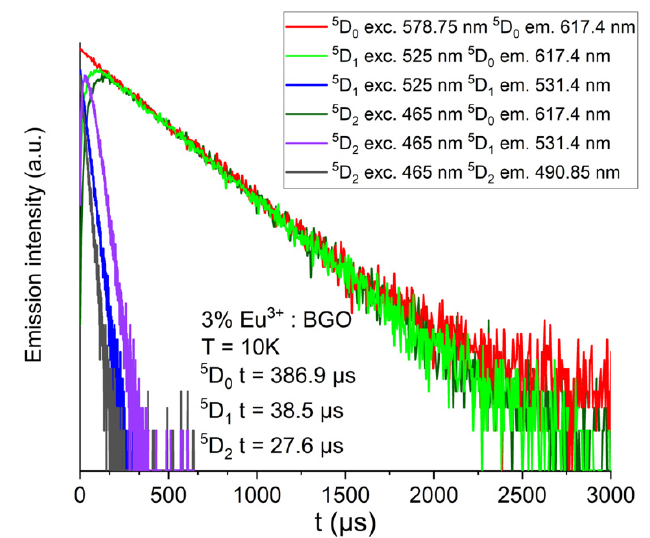
Figure 9. Bi 3 + decay times relative to the Eu 3 + concentration (measured at T = 300 K). Figure 9. Bi 3+ decay times relative to the Eu 3+ concentration (measured at T = 300 K).